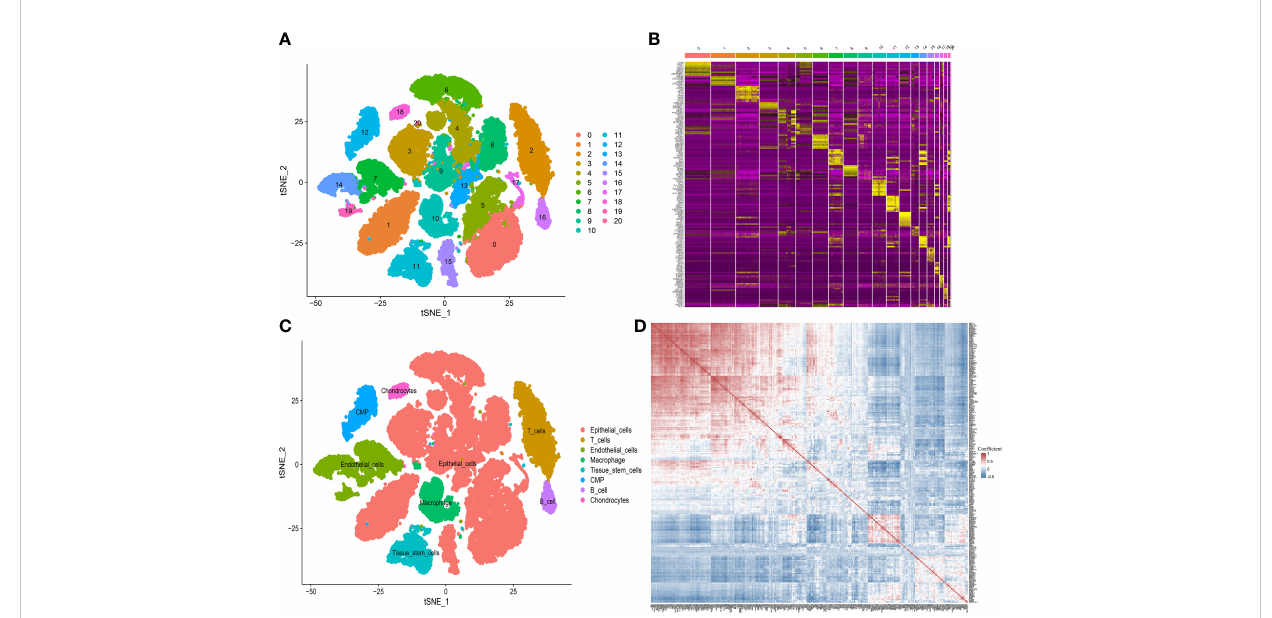
FIGURE 2 De fi nition of MRMGs by scRNA-seq analysis. (A) t-SNE plot displaying 21 cell-related clusters. (B) Heatmap displaying top 10 marker genes in 21 clusters (https://postimg.cc/2bK9wfXT). (C) t-SNE plot displaying 8 annotated cell types. (D) Heatmap displaying the correlation between 307 identi fi ed MRMGs (https://postimg.cc/cvFkkdVY). t-SNE, t-distributed stochastic neighbor embedding; CMP, common myeloid